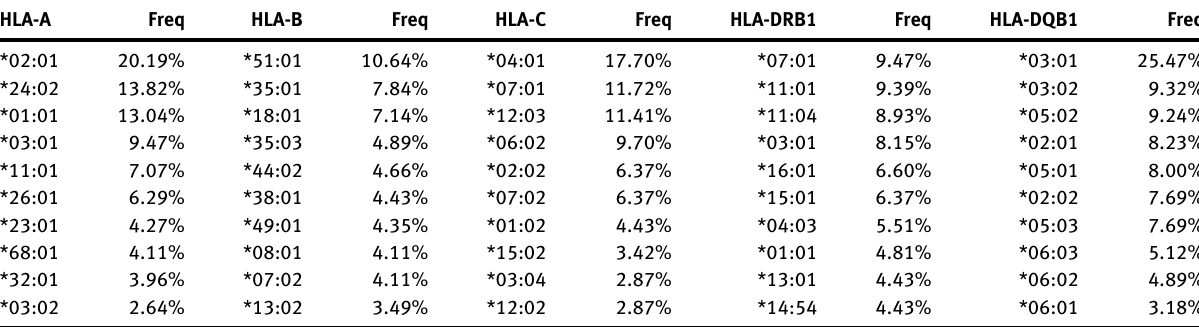
Table  : HLA class I and II allele frequencies ( fi rst  most frequent alleles shown here). HLA-A Freq HLA-B